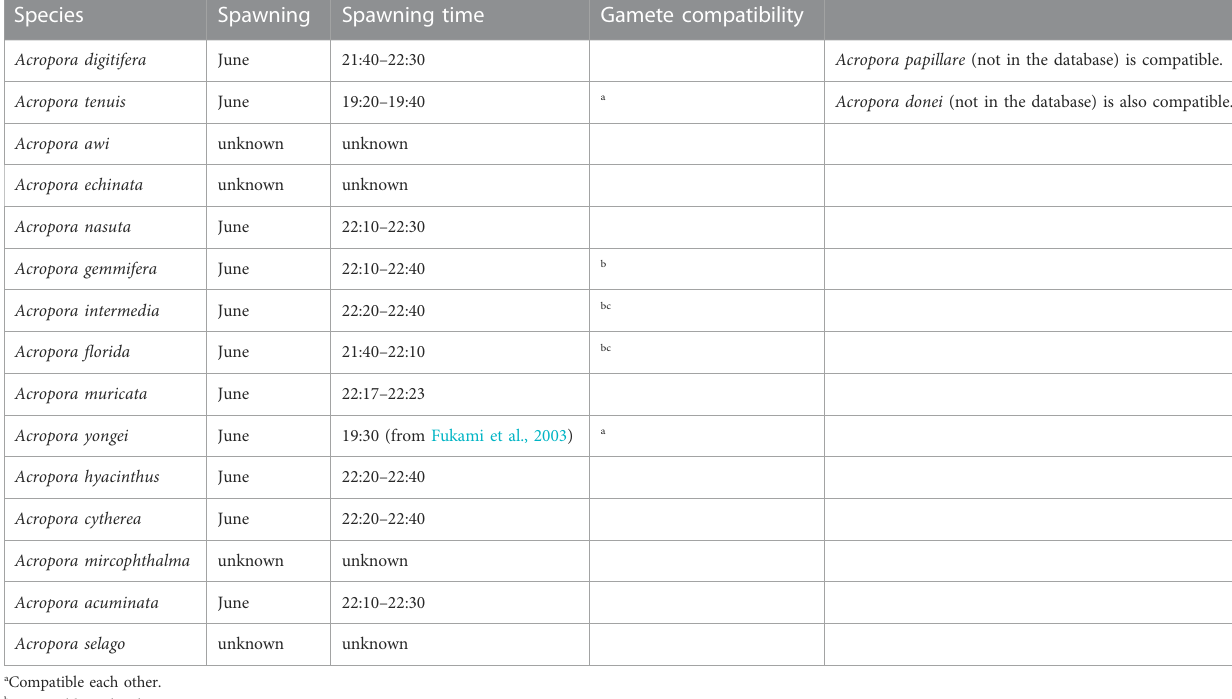
TABLE 2 Spawning synchronisms and gamete compatibility in the Acropora of the database of Orthoscope. Species Spawning Spawning time Gamete compatibility